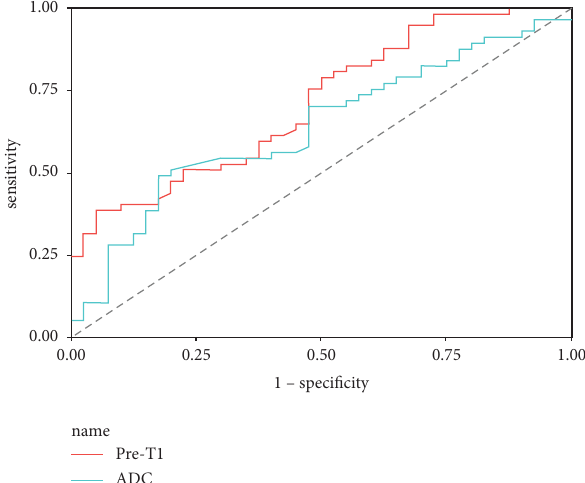
Figure 4: Receiver operating characteristic (ROC) curve of parameters for predicting the Ki-67 expression level. Pre-T1 showed a good diagnostic performance; its area under the curve was